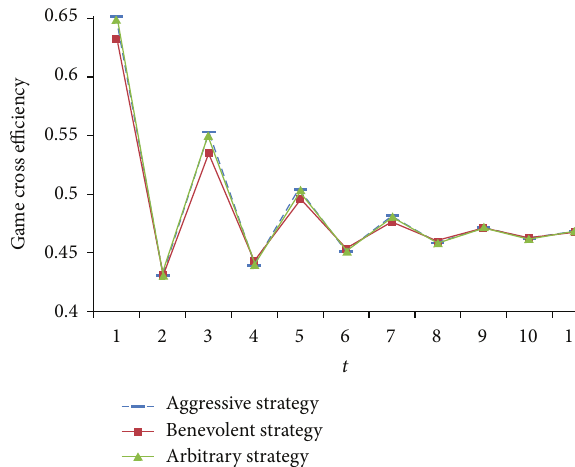
Figure 4: Iteration process for the second stage of